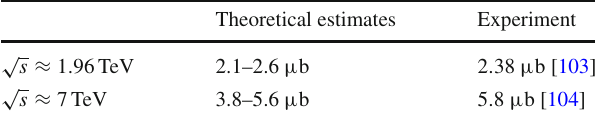
Table 1 Comparison of the theoretical estimates with experimental data for the cross-section d σ/ dy at central rapidities. Theoretical esti- mates correspond to values of parameter λ ∈ ( 0 . 2 , 0 . 3 ) (lower and upper values respectively). In the last column we’ve quoted the data on prompt J /ψ production. The cross-section d σ/ dy at Tevatron was extracted dividing the total cross-section σ tot ( | y | < 0 . 6 ) by the width of the bin (cid:5) y ∼ 1 .